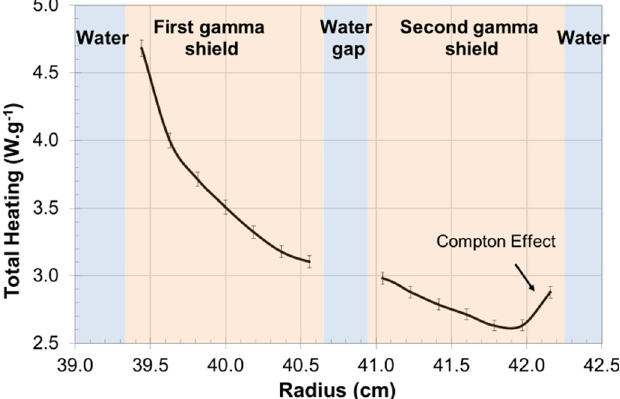
Fig. 7. Photonic spectrum taken at the internal and external gamma shield